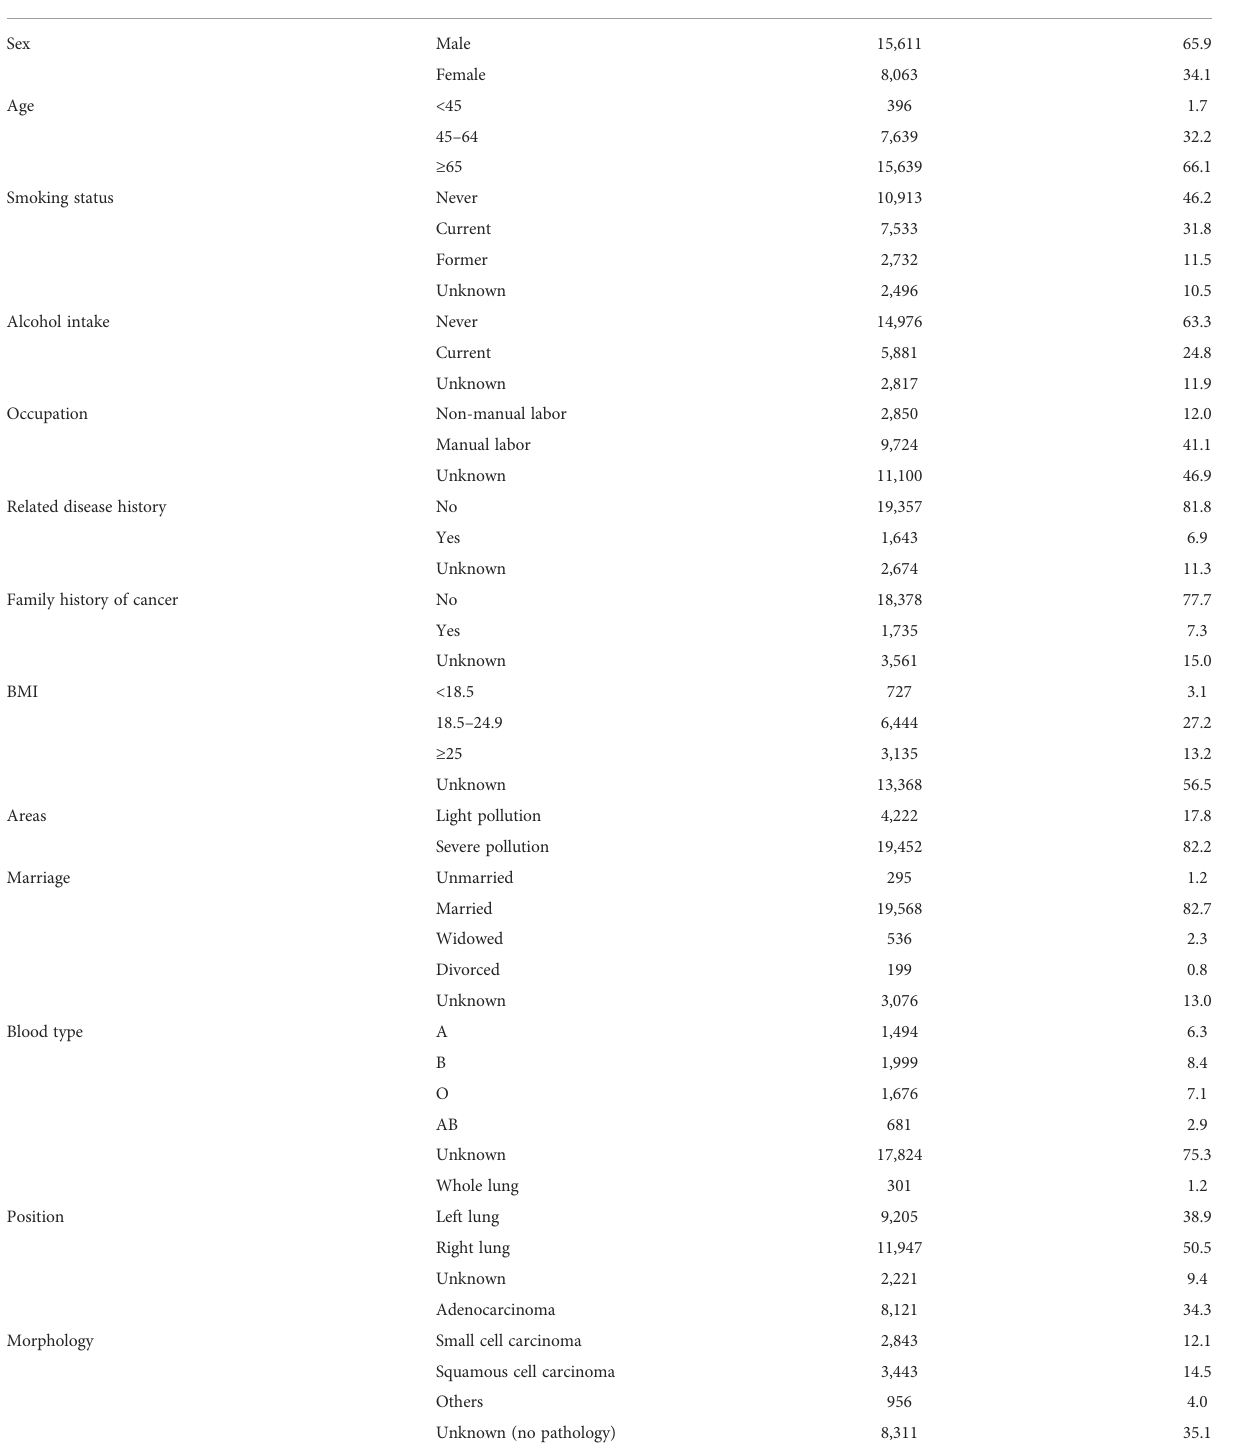
TABLE 1 Distribution of clinical characteristics in patients with lung cancer in Hebei Province, 2010 –